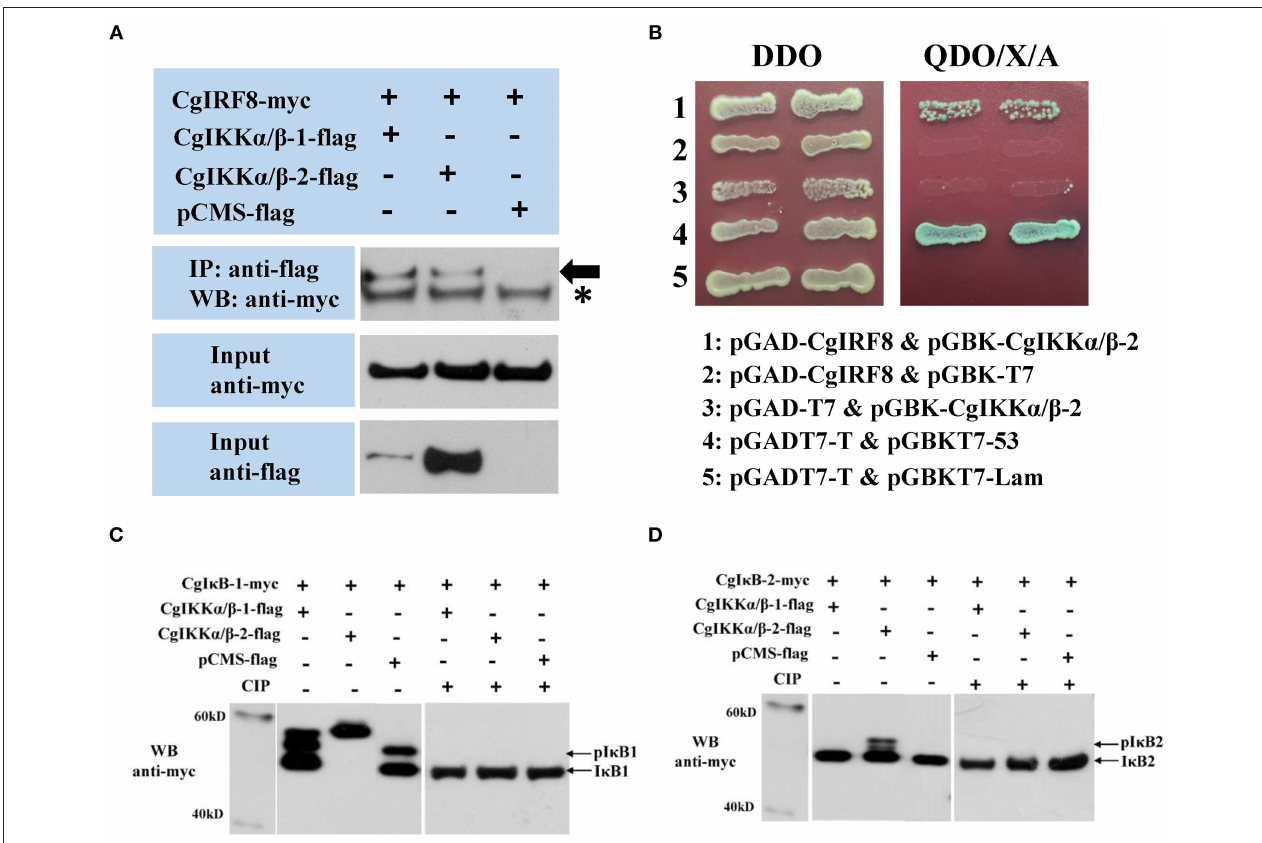
FIGURE 9 | CgIKK α / β -1 and CgIKK α / β -2 recruit oyster IRF8 and may phosphorylate oyster I κ B proteins. (A) Interaction between CgIKK α / β -1 (or CgIKK α / β -2) and CgIRF8 was detected by Co-IP assays. Anti-Myc western blot bands show the expression of CgIRF8-Myc and anti-FLAG western blot bands show the expression of CgIKK α / β -1-FLAG and CgIKK α / β -2-FLAG. Asterisk represents the heavy chain of mouse IgG. (B) Interaction between CgIKK α / β -2 and CgIRF8 was confirmed by Y2H assay. (C) CgIKK α / β -1 and CgIKK α / β -2 may phosphorylate oyster I κ B1. HEK293T cells were seeded in 6-well plates at 10 7 cells per well overnight